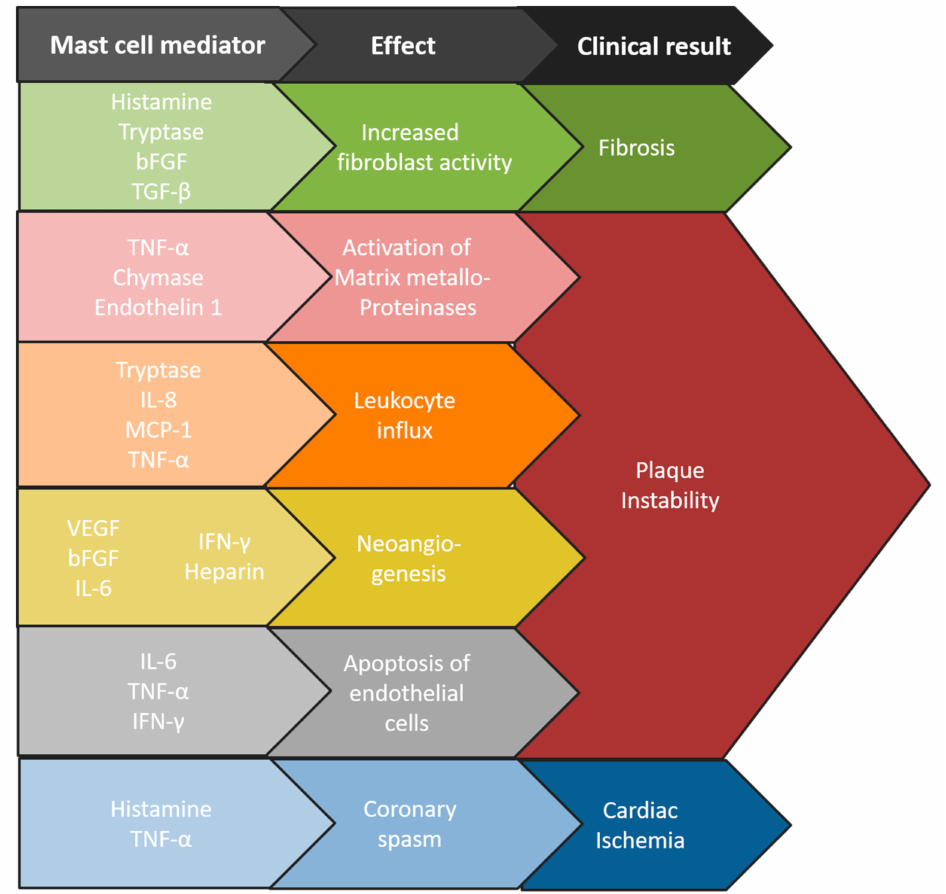
Figure 2. Mast cells (MC) mediators promote di ff erent aspects of cardiovascular disease. Upon activational signals from their environment, mast cells produce di ff erent kinds of mediators, which in their turn have pro-inflammatory or pro-fibrotic e ff ects on the blood vessel wall and atherosclerotic plaque. For an explanation on the di ff erent substances, please see the text of the